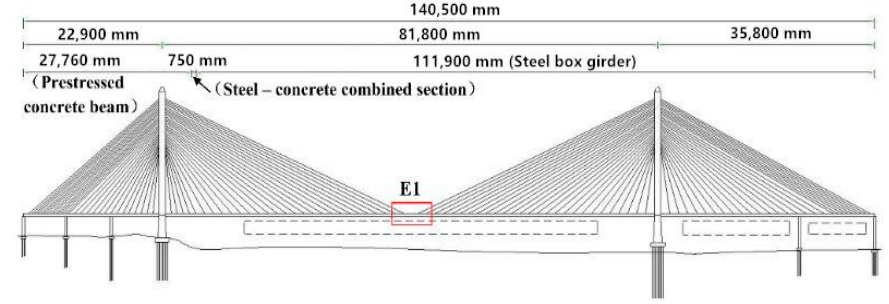
Figure 6. The bridge structure layout.